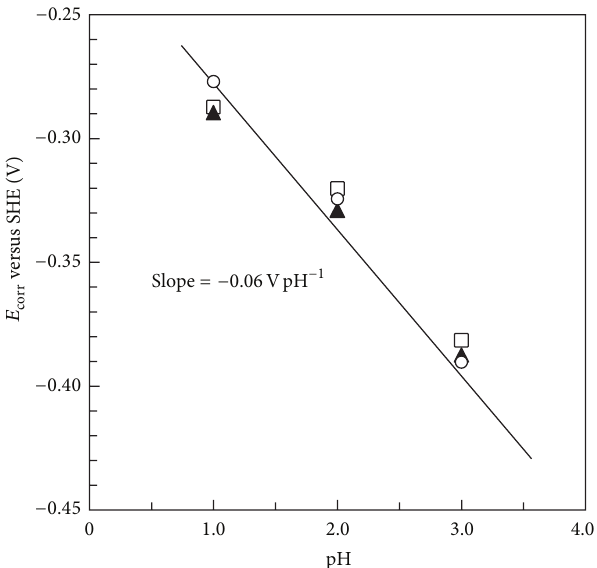
Figure 7: Effect of pH on the anodic current density in sulfuric acid solutions at 𝐸 = −0.30 V. The ratio of pearlite area, 𝑃 𝑟 : ( ∙ ) 0, ( ◻ ) 0.08, ( 󳵳 ) 0.29, and ( I ) 0.57.